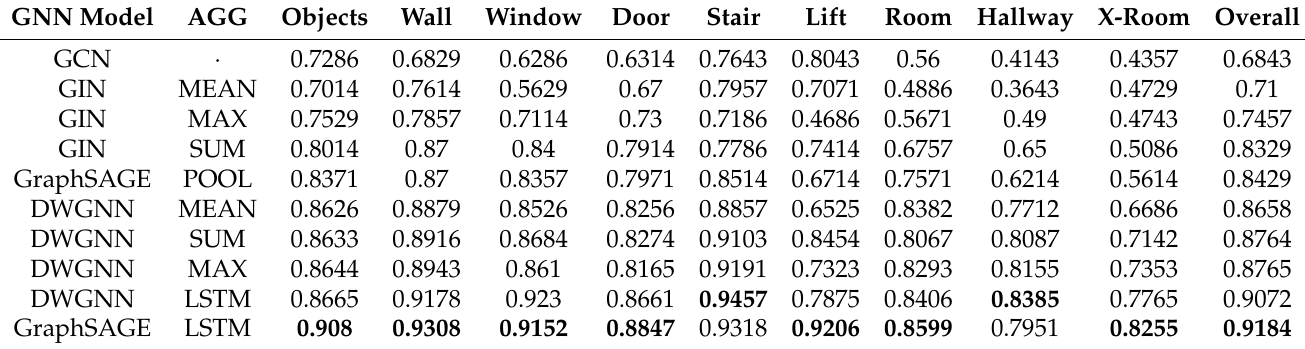
Table 2. Class-wise accuracy comparison on different GNN models on the UOS data set.